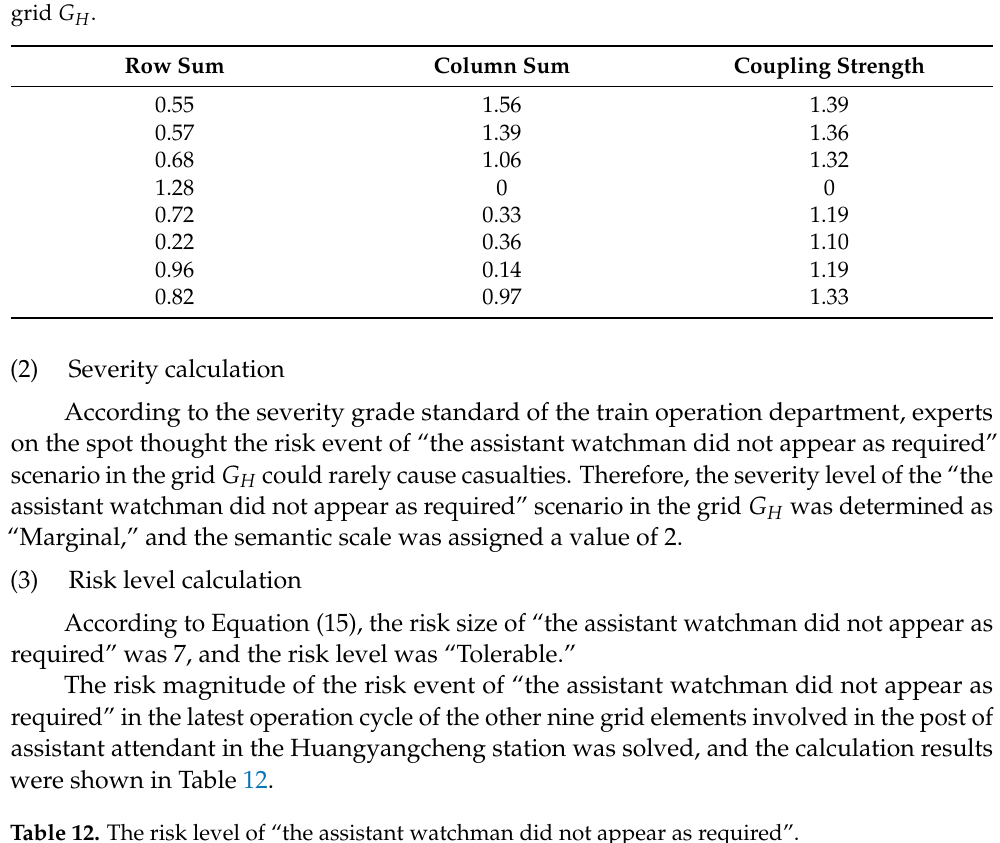
Table 12. The risk level of “the assistant watchman did not appear as required”. Grid